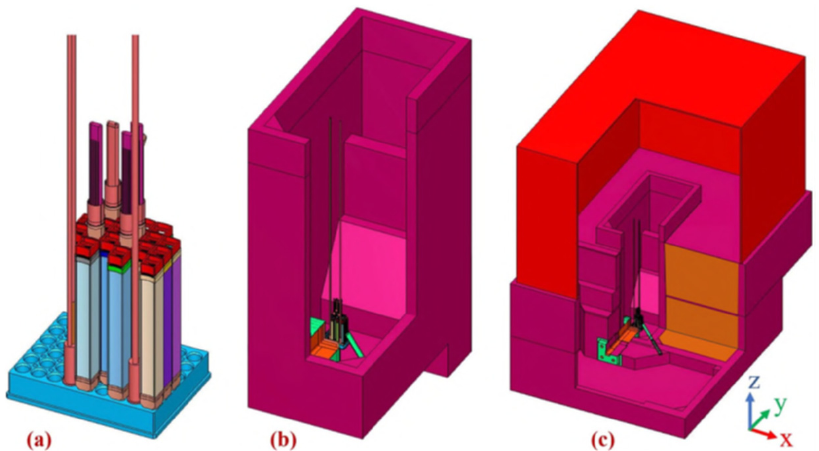
Figure 6. Three geometrical configuration models used in SCALE6 ( a ) the MSTR core, ( b ) the MSTR pool, and ( c ) the high-fidelity model, which includes the pool and entire MSTR building structure. Figure is taken from [13].